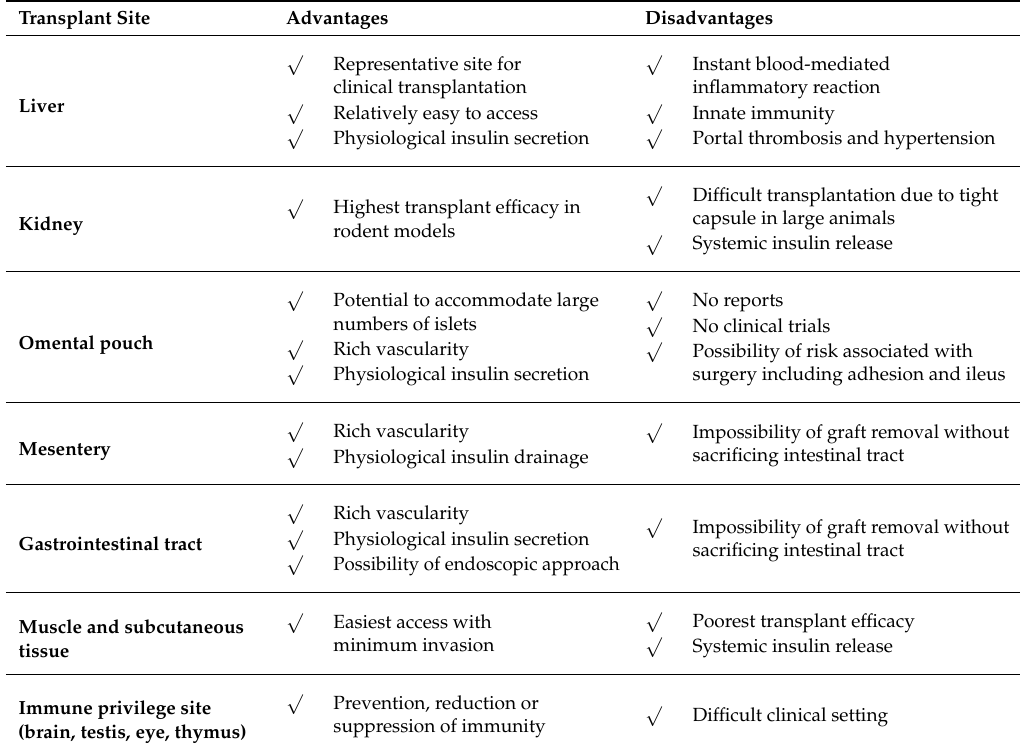
Table 1. Candidate islet transplantation sites other than the